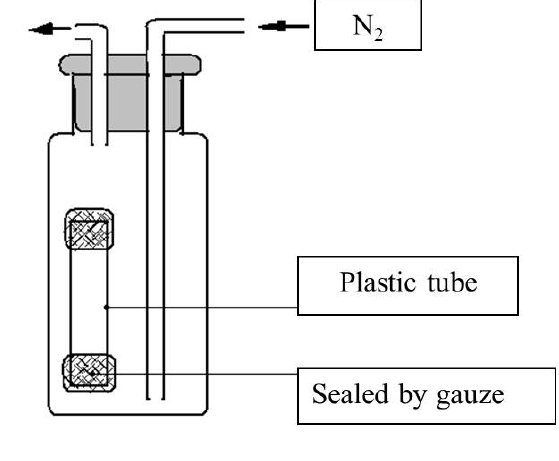
Figure 7. Schematic diagram of apparatus to test anoxia